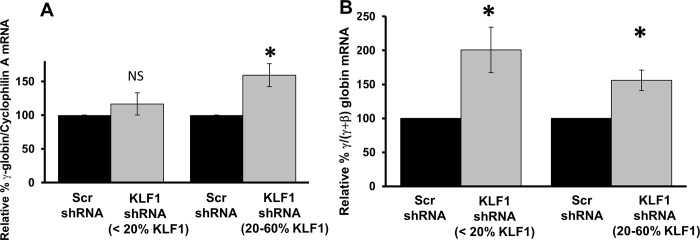
γ-globin mRNA amounts with modest and robust KLF1 knockdown.UCB samples were divided into two groups based on the amount of residual KLF1 mRNA after knockdown (see supplementary Fig 2B). The first group consists of samples which showed robust KLF1 knockdown (<20% residual KLF1; N = 10). The second group had modest knockdown of KLF1 (20–60% residual KLF1, N = 9). The primers for γ-globin collectively measure Aγ- and Gγ-globin mRNA. A) Absolute amounts of γ-globin mRNA are increased above normal only in the presence of a threshold amount of KLF1. Within each group, the fold change in γ-globin expression in KLF1 shRNA-treated cells was calculated by setting the amount of γ-globin mRNA in Scr shRNA-treated controls to 100. Cyclophilin A mRNA was used as the internal standard for qPCR. Error bars = standard error, * = p-value<0.005, NS = not significant. (B) γ-globin is increased relative to total (γ+β)-globin with any amount of KLF1 knockdown. The amount of γ-globin mRNA in Scr and KLF1 shRNA-treated cells was measured by qRT-PCR and reported as a fraction of total (γ+β)-globin mRNA. In each group the fold change in γ-globin expression in KLF1 shRNA-treated cells was calculated by setting the amount of γ-globin in Scr shRNA-treated controls to 100. Error bars = standard error, * = p-value<0.01.